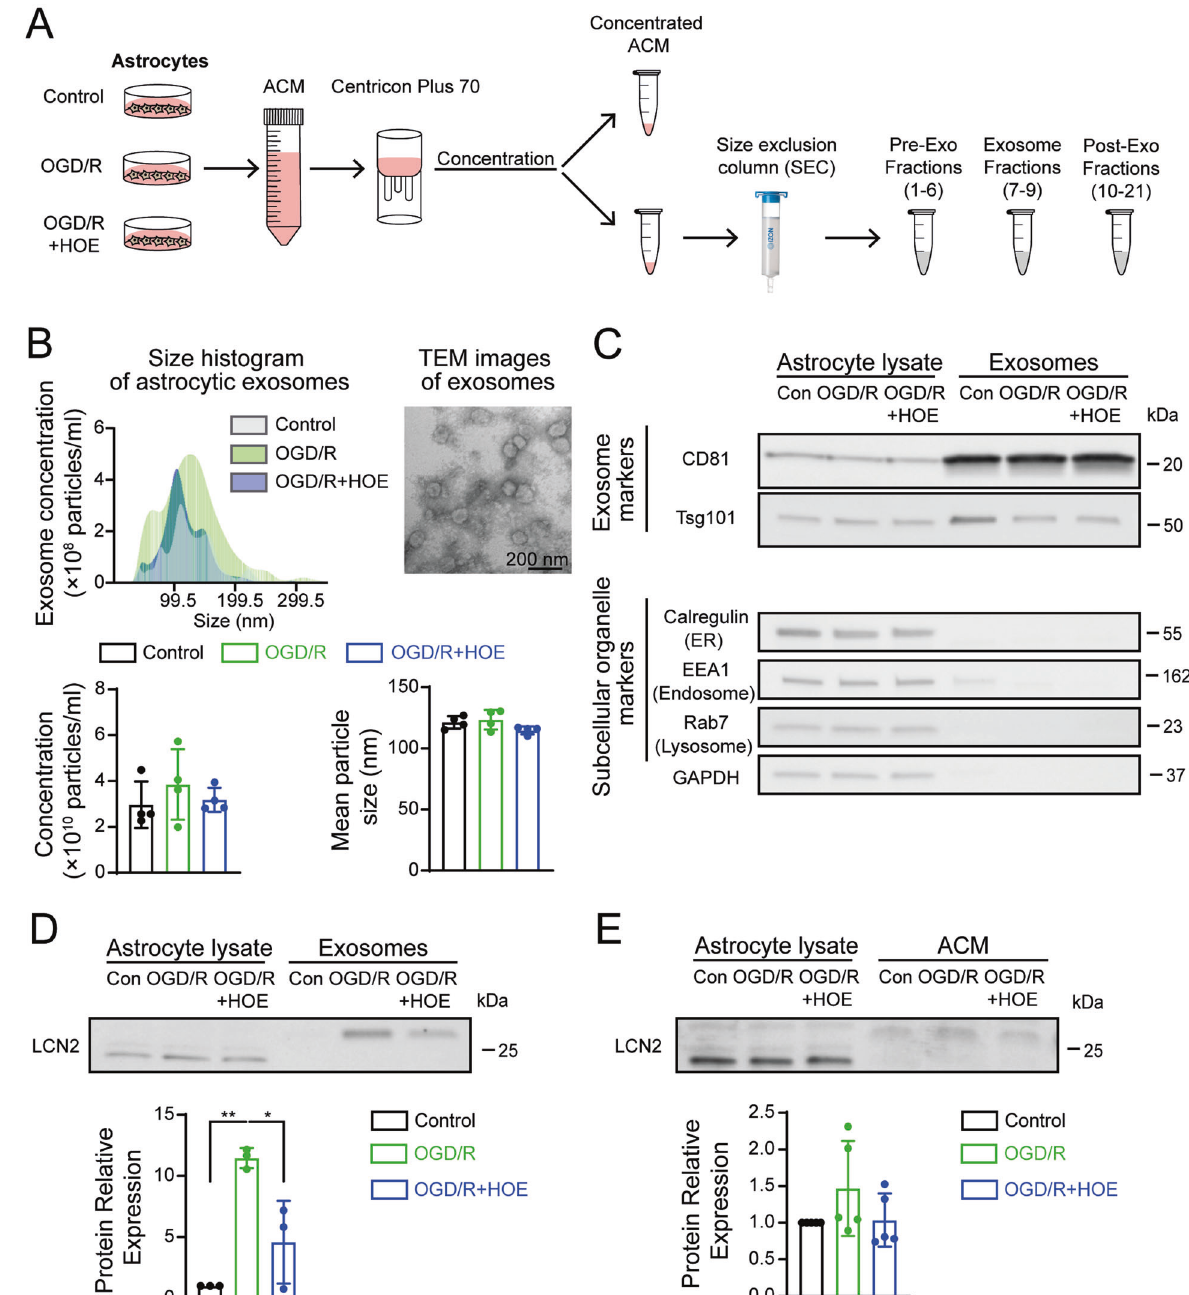
Fig. 4 In vitro ischemia-induced differential changes in exosome LCN2 expression in primary astrocytes in presence or absence of HOE642. A Cartoon illustrates ACM concentration and exosomes isolation. B Representative size distribution of exosomes isolated from ACM of control, OGD/R and OGD/R + HOE642 treated astrocytes by NTA and representative TEM images of exosomes. Bar graph represents the quanti fi cation of exosome concentration and mean particle size. Data are mean ± SD, n = 4. C Representative immunoblots of exosome markers and other subcellular organelles speci fi c protein markers in whole-cell lysates and puri fi ed exosome fractions. D Representative immunoblots of LCN2 in whole-cell lysate and exosome fractions. Bar graph represents the quanti fi cation of LCN2 band intensity. Data are mean ± SD, n = 3. * p < 0.05; ** p < 0.01 via one-way ANOVA. E Representative immunoblots and quanti fi cation of LCN2 expression from astrocyte lysate and ACM isolated from control, OGD/R and OGD/R + HOE642 treated astrocytes. Data are mean ± SD, n = 4. * p < 0.05; ** p < 0.01; *** p < 0.001 via one-way further evaluated neuronal damage by immunostaining for loss of neurons were treated with 2 or 4 μ g/ml Re-LCN2 for 48 h and microtubule-associated protein -2 (MAP-2) expression or increase neuronal viability was measured by calcein/PI staining (Fig. 5A). As in apoptotic marker caspase-3 (cleaved) expression. MAP-2 is shown in Fig. 5B, Re-LCN2 treatment caused a signi fi cant increase localized predominantly to the neurites and perikaryon of intact in PI + neurons ( Arrows , Fig. 5B), which failed to retain cellular neurons and loss of MAP-2 expression is indicative of neuronal calcein staining, indicating LCN2-mediated neuronal damage. We